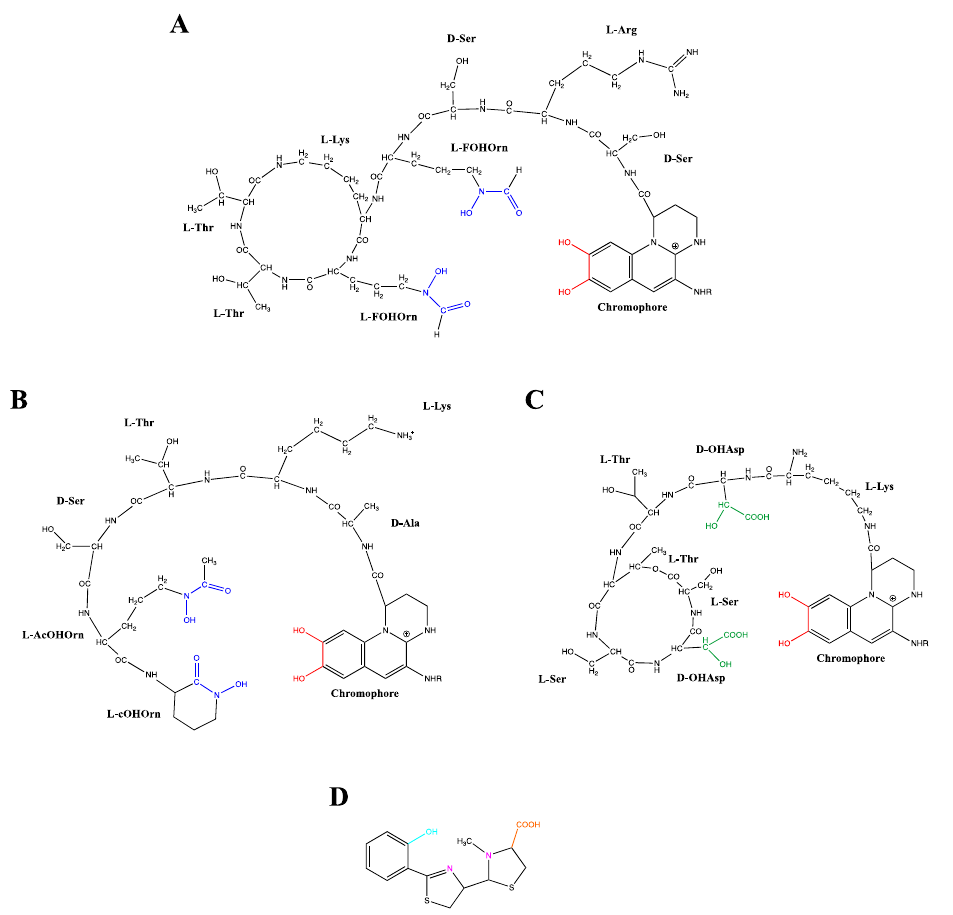
Figure 2. Structures of the pyoverdines from Pseudomonas aeruginosa ( A ), Pseudomonas mandelii ( B ) and Pseudomonas syringae ( C ) and structure of pyochelin from Pseudomonas aeruginosa ( D ). The pyoverdine ligand groups catecholate, hydroxamate and hydroxy-carboxylate are, respectively, highlighted in red, blue and green. The pyochelin ligand groups phenolate, imine/tertiary amine and carboxylate are respectively highlighted in turquoise, pink and orange. FOHOrn: δ N-formyl- δ N-hydroxy-ornithine; AcOHOrn: δ N-acetyl- δ N-hydroxy-ornithine; cOHOrn: cyclo-hydroxy-ornithine; OHAsp: threo-ß-hydroxy-aspartic acid.